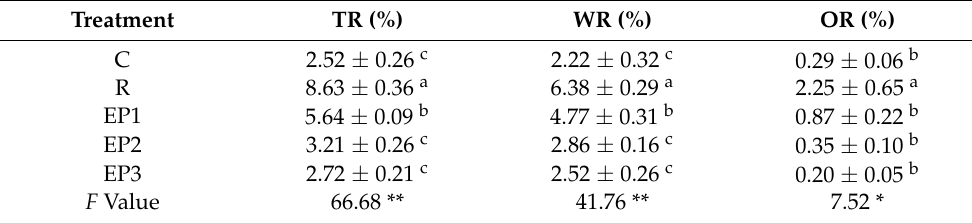
Table 3. Water-and fat-binding properties of pork sausages. Treatment